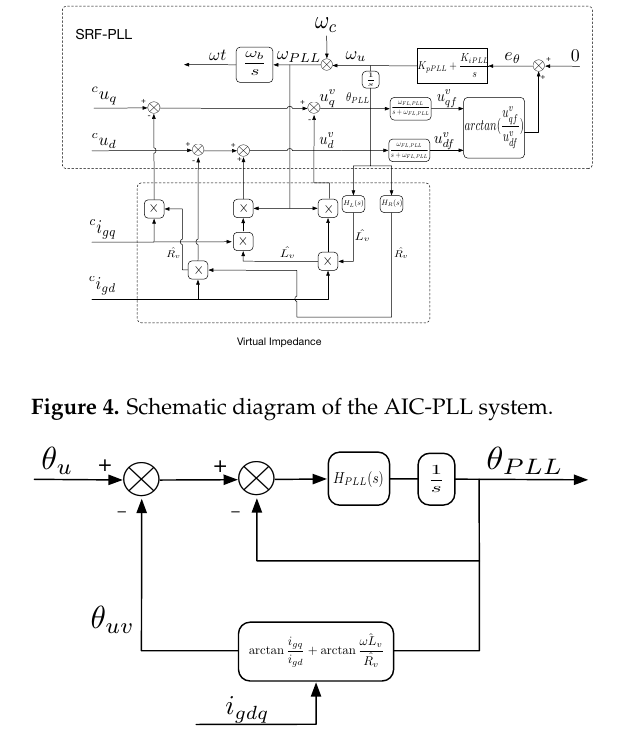
Figure 5. Simplified model of the